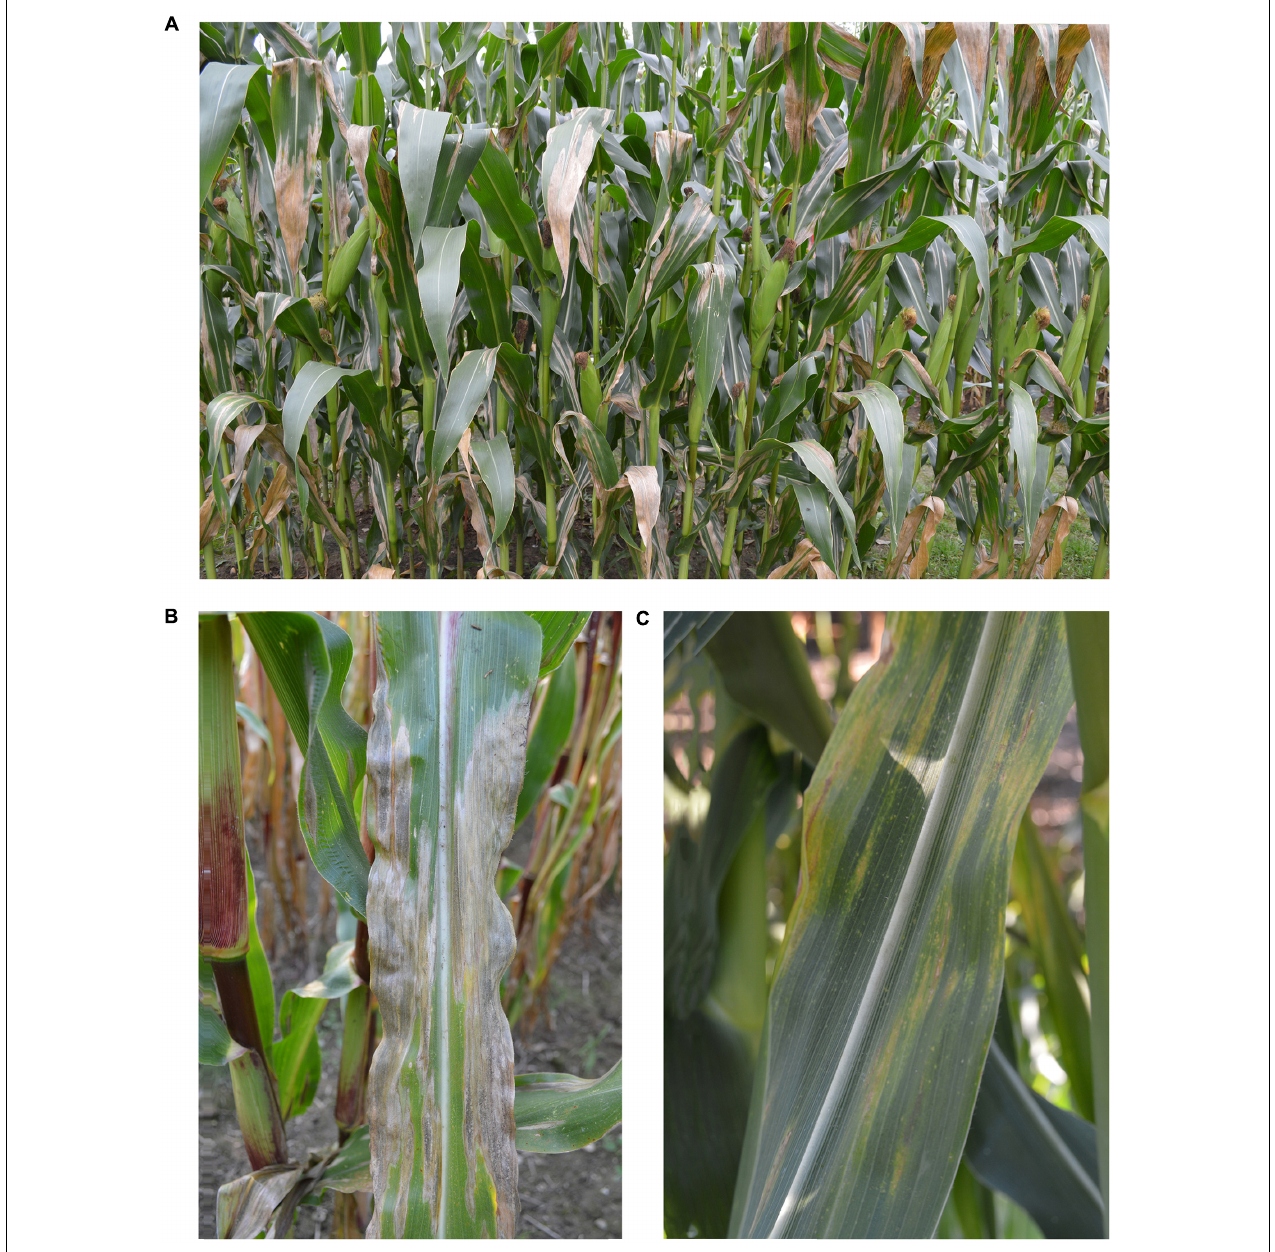
FIGURE 1 | Northern corn leaf blight symptoms. (A) Symptoms of Setosphaeria turcica on a maize field with a susceptible cultivar. (B) Single leaf of a susceptible cultivar with symptoms of S. turcica, and (C) Single leaf with resistance reaction (Photos: Dr. Lucia Ramos-Romero, University of Göttingen,